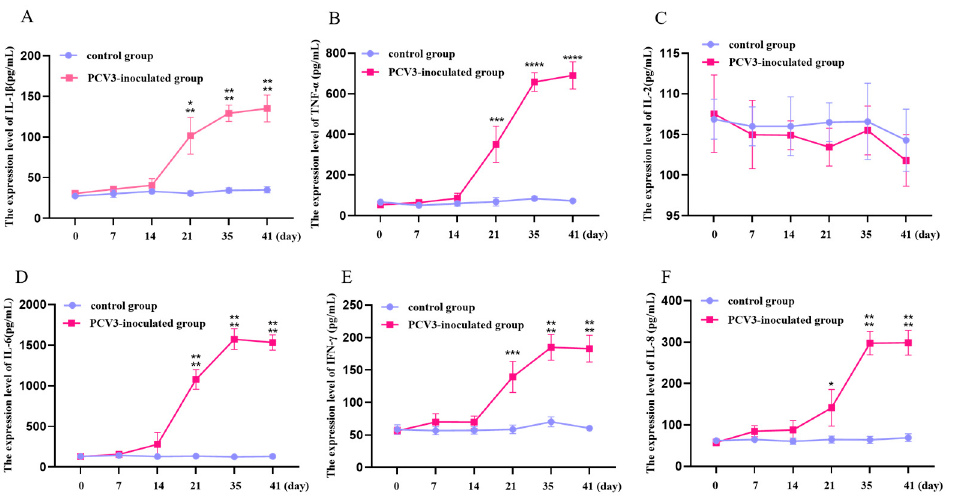
Figure 4. The production of cytokines in serum between the control group and PCV3-inoculated group. A : The expression level of IL-1 β ; B : The expression level of TNF-a; C : The expression level of IL-2; D : The expression level of IL-6; E : The expression level of IFN- γ ; F : The expression level of IL-8.